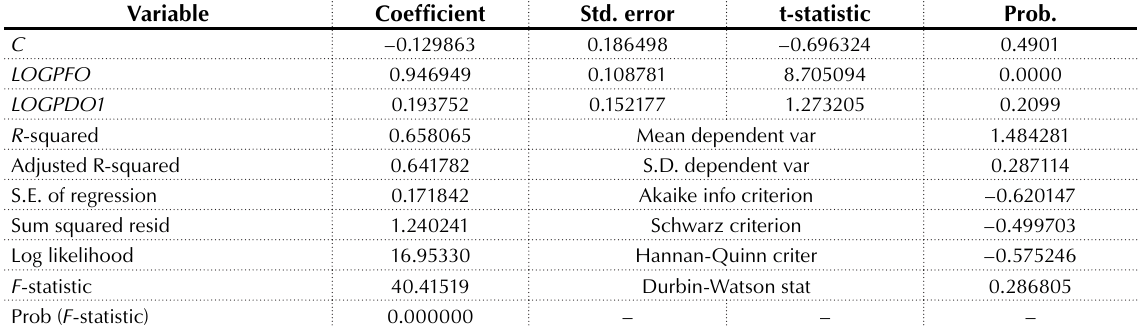
Table 2. Hausman economic growth